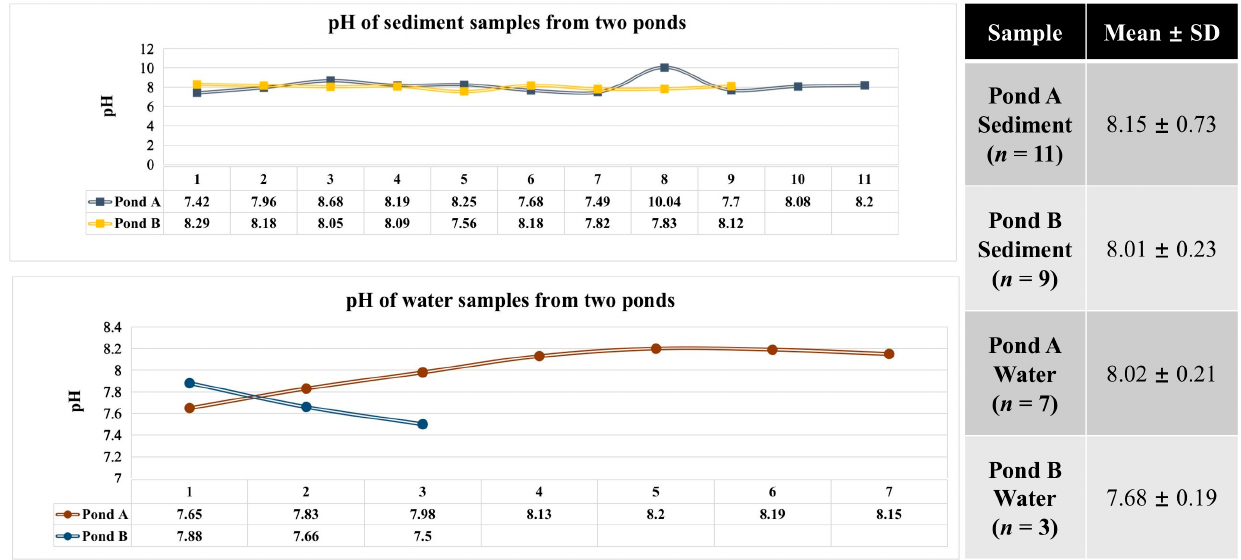
Figure 2. pH values of water and sediment from Pond A and Pond B of the Julong hot